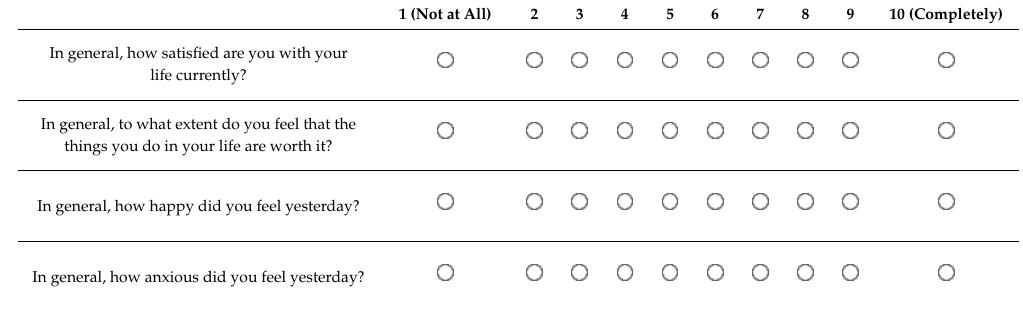
Figure A2. Google Earth aerial images used: ( A ) Freire, ( B ) Lumaco, ( C ) Pucón, ( D ) Curarrehue. (Scale of 1:10,000).